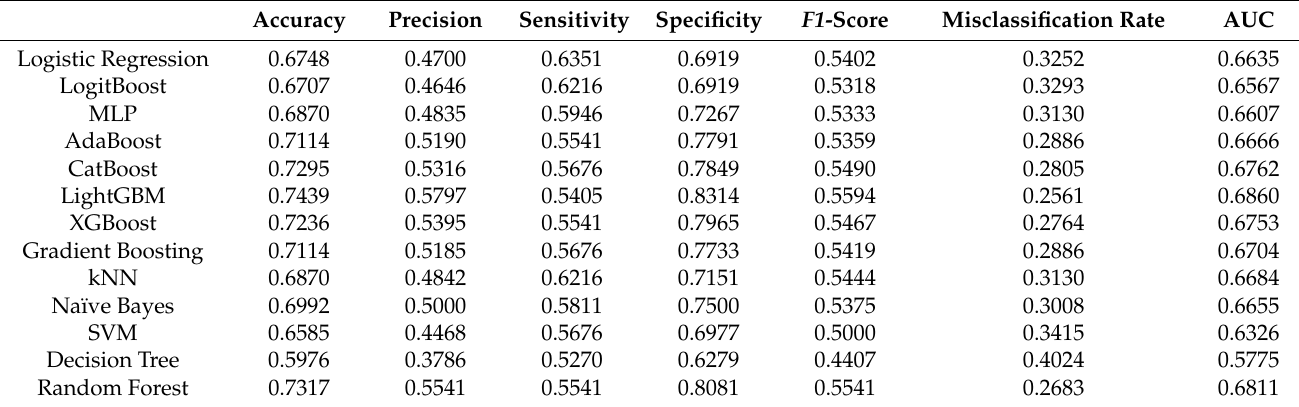
Table 8. Performances of the models using the optimum hyperparameters